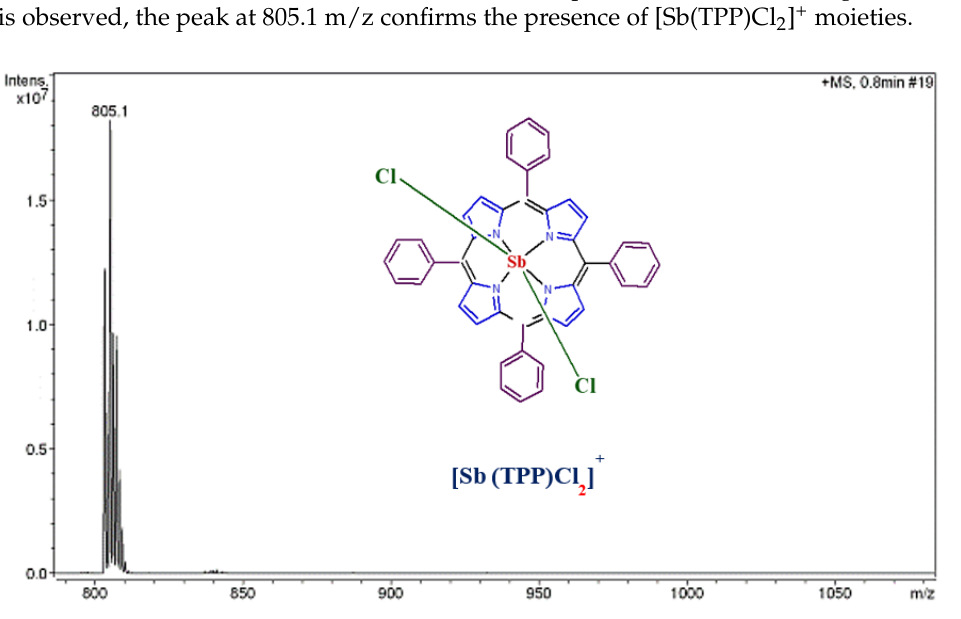
Figure 1. Positive EIS mass spectrum of [Sb(TPP)Cl 2 ]. Solution was prepared by diluting 5 × 10 − 3 M dichloromethane solution to 5 × 10 − 5 M in acetonitrile.